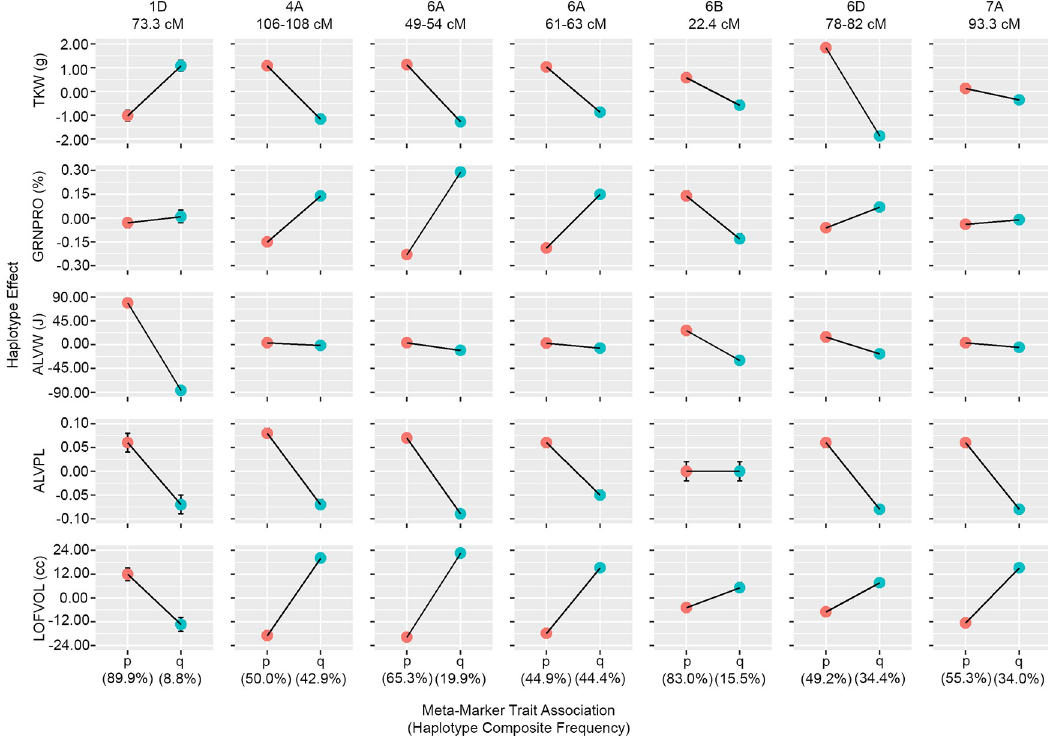
Fig 4. Meta-marker trait associations for seven significant multi-trait associations. Meta effect of each haplotype is displayed with marker frequencies. Effects are demonstrated for thousand kernel weight (TKW), grain protein (GRNPRO), Alveograph W (ALVW) and P/L (ALVPL), and loaf volume (LOFVOL) traits.